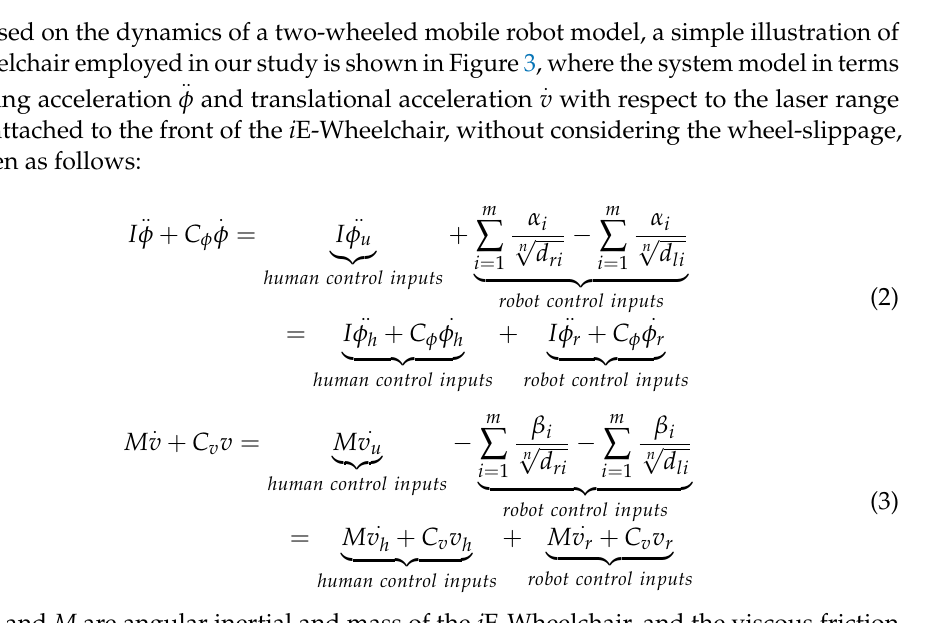
Figure 3. A cartoon representation of our i E-Wheelchair with the differential-drive kinematics.